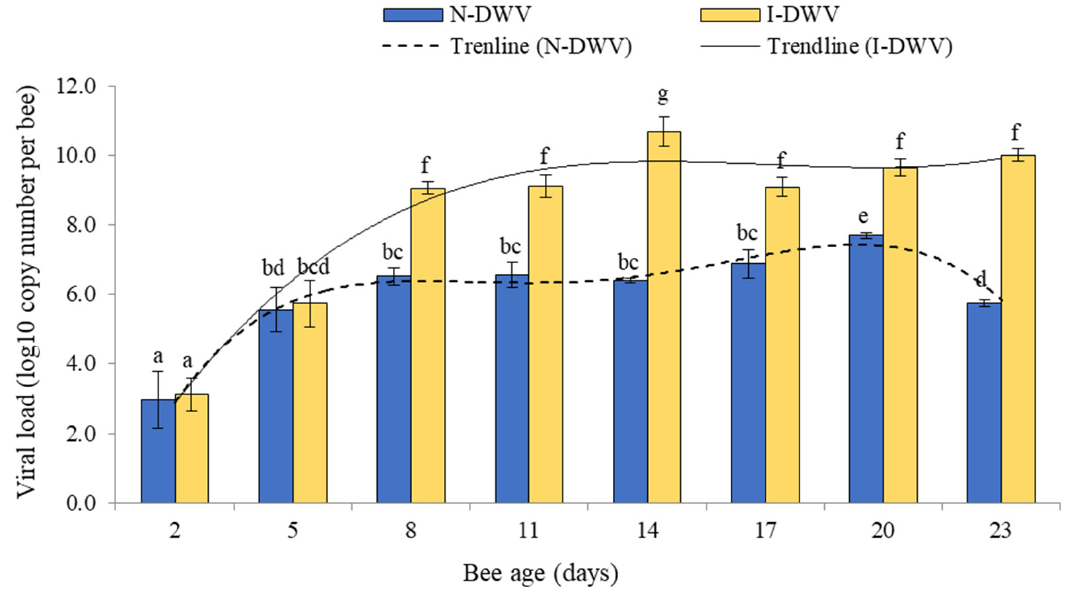
Figure 3. DWV-A load measured in antennae of worker honey bees of different ages that were inoculated (I-DWV) and non-inoculated (N-DWV). Means ( ± SE) with different letters indicate significant difference according to the Tukey HSD test ( p < 0.05). Values of DWV-A load in 2-day old bees indicate the basal level of viral infection before the inoculation.